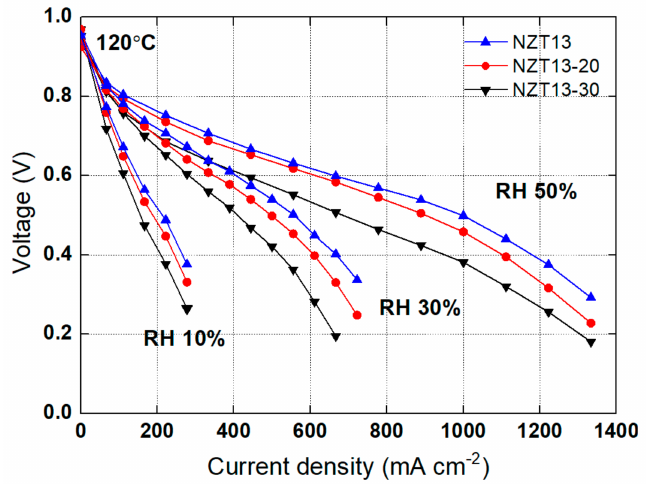
Figure 8. Polarization curves for the NZT13 with different inorganic ZT content (10, 20, and 30%) at 120 ◦ C, RH 50, 30, 10%, and 2